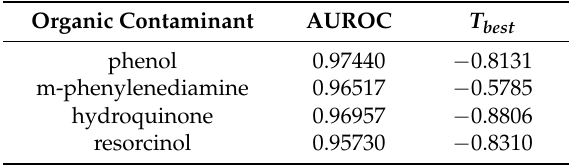
Table 2. Parameters of semi-supervised model for different contaminants.